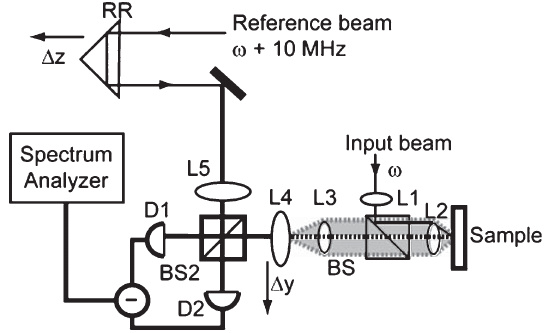
Fig. 1. Schematic of a time domain a/LCI system. Axial translation of retroreflector (RR) scans the pathlength of the reference arm to enable optical sectioning via coherence gating. Lenses L1–L4 are configured as shown to permit a collimated incident on the sample, and L4 to lie in the image plane of the scattered light (shaded). By scanning L4, the intensity of scattered light is mapped as a function of the scattering angle. Taken from